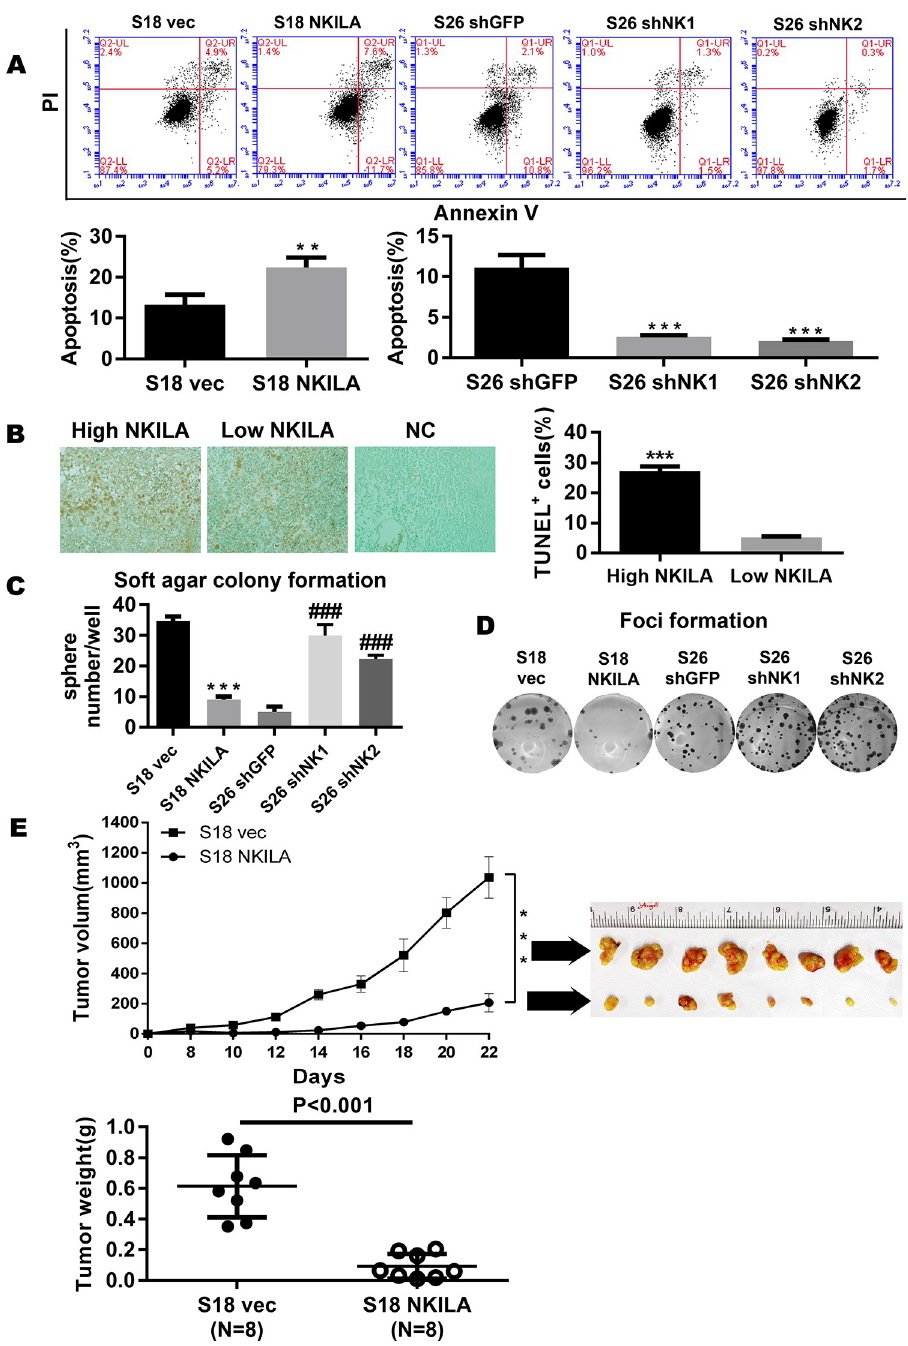
Fig 4. NKILA represses the tumorigenesis of NPC. (A) Apoptosis of control vector or NKILA-overexpressing S18 cells and shGFP or shNKILA S26 cells as assayed by ANNEXIN-V/PI staining (mean ± SD, n = 3, ��� < 0.001 versus S26 shGFP, �� < 0.01versus S18 vec). (B) Tunnel assay revealing the correlation between NKILA and apoptosis in 65 paraffin-embedded NPC specimens. (C) Anchorage-independent growth of control vector or NKILA-overexpressing S18 cells and shGFP or shNKILA S26 cells in soft agar. Over 14 days of culture, number of colonies was calculated at 10 randomly ten fields of view. Original magnification, × 100. (Error bar represent SD. Mean ± SD, n = 3, ��� , P < 0.001 versus S18 vec; ###, P < 0.001 versus S26 shGFP). (D) Foci formation by control vector or NKILA-overexpressing S18 cells and shGFP or shNKILA S26 cells were performed as described in the Methods. (E) Tumor formation in nude mice: S18 (vec, NKILA) cells were injected and tumor volumes were calculated and plotted as described in the Methods. The upper panel shows the tumor growth and tumor volume in mice (S18 vector control, S18 NKILA